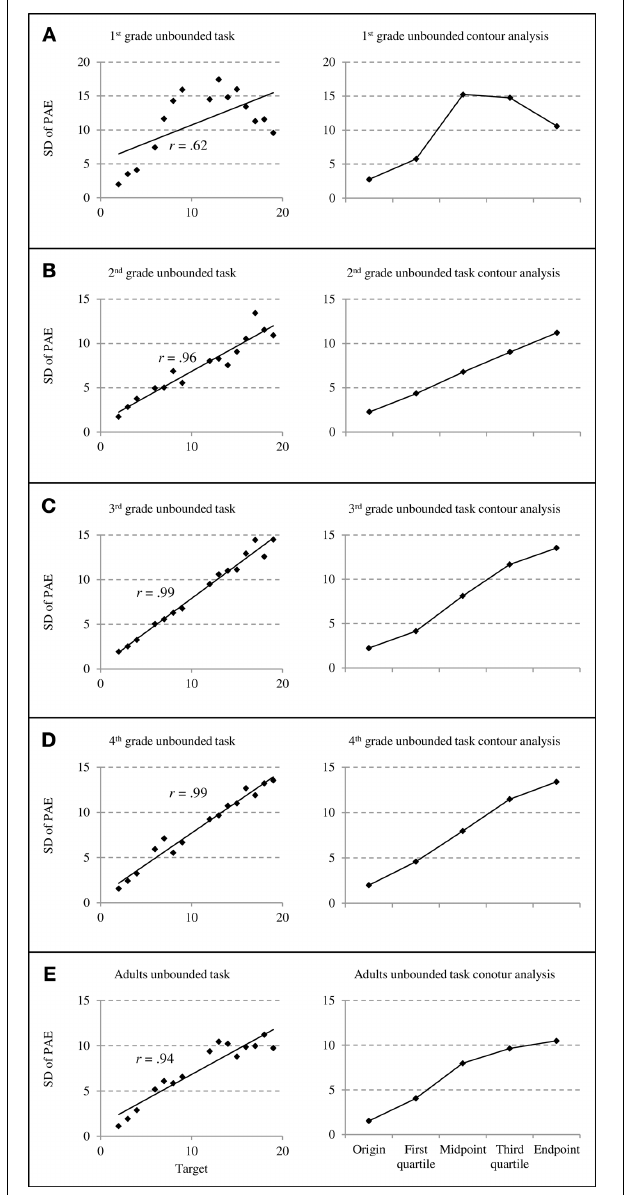
FIGURE 4 | Standard deviations of percent absolute errors (PAE) for unbounded number line estimation performance. The left column depicts the relationship between standard deviations of PAEs and target numbers whereas the right column depicts results of counter analyses summarizing standard deviations of PAEs at specific reference points ( cf. Ashcraft and Moore, 2012; grade 1 through adults: A – E)